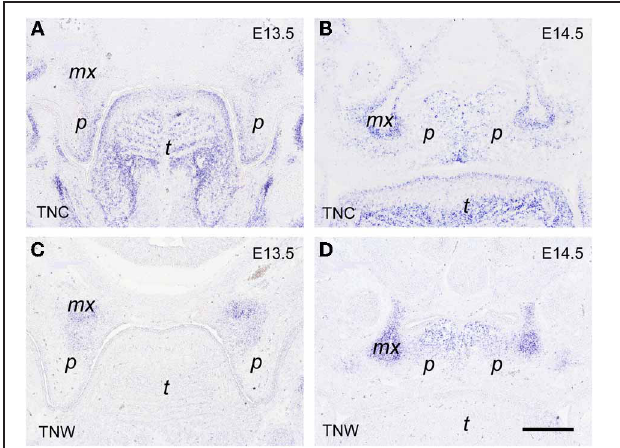
FIGURE 4 | In situ hybridization for fibronectin (FN; A,B) and Tgf- β 3 (C,D) mRNA, respectively, on frontal sections through the heads of E14.5 Bmp 7 + / − (A,C) and Bmp 7 − / − (B,D) mouse embryos (anterior level). Note fibronectin mRNA expressed by midline epithelial cells in the Bmp 7 + / − embryo (A) , whereas epithelial expression is almost absent in the palatal shelves of the Bmp 7 − / − embryo at the same stage (B) .